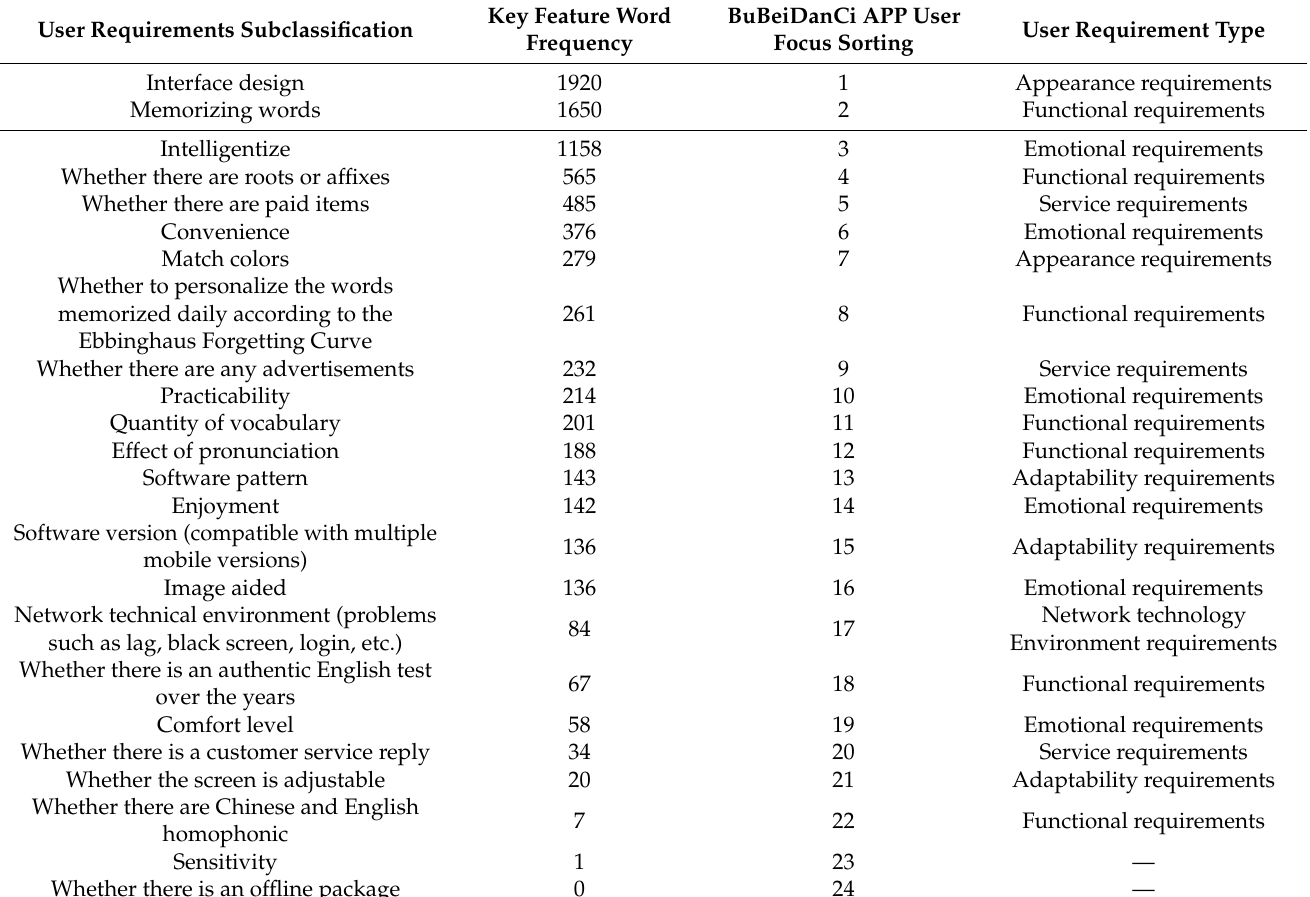
Table 10. BuBeiDanCi user requirement elements